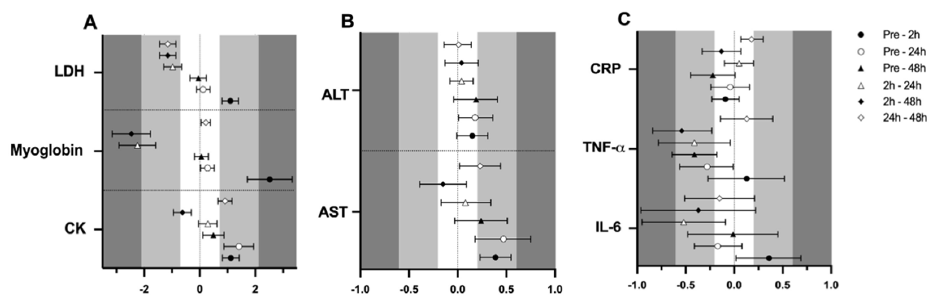
Figure 3. Standardized mean differences (ES) and confidence intervals in muscle damage and inflammation markers among time-point measurements. ( A )CK, myoglobin and LDH; ( B )AST and ALT; ( C )IL-6, TNF- α and CRP; EFP: early follicular phase, LFP: late follicular phase, MLP: